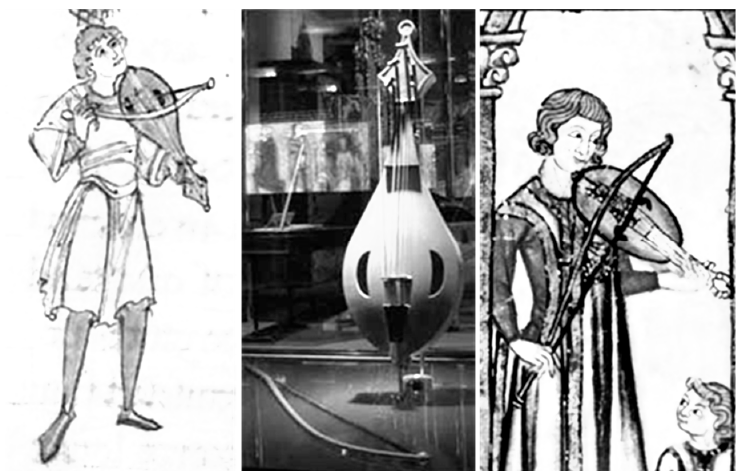
Figure 2. Initial paintings show the emergence of sound ‐ holes in musical instruments Roman fiddle adapted from the manuscript London Br. Libr., Arundel. 91 (fol°218v°), eginning of the 12th Century (left), Vièle recreated for the Museu de la música in Barcelona, 2006 (center), Gothic fiddle, Cantigas de Santa Maria, Spain, 13th Century (right) (Rault 2014).